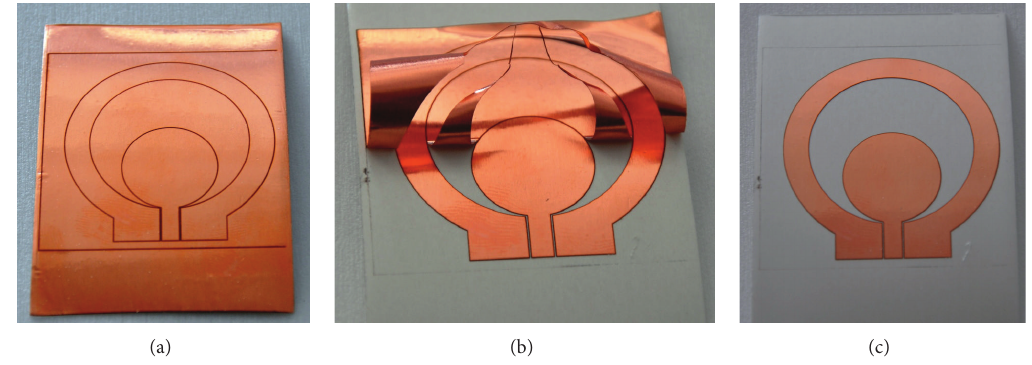
Figure 3: Photographs of manufactured antenna on a copper adhesive tape.